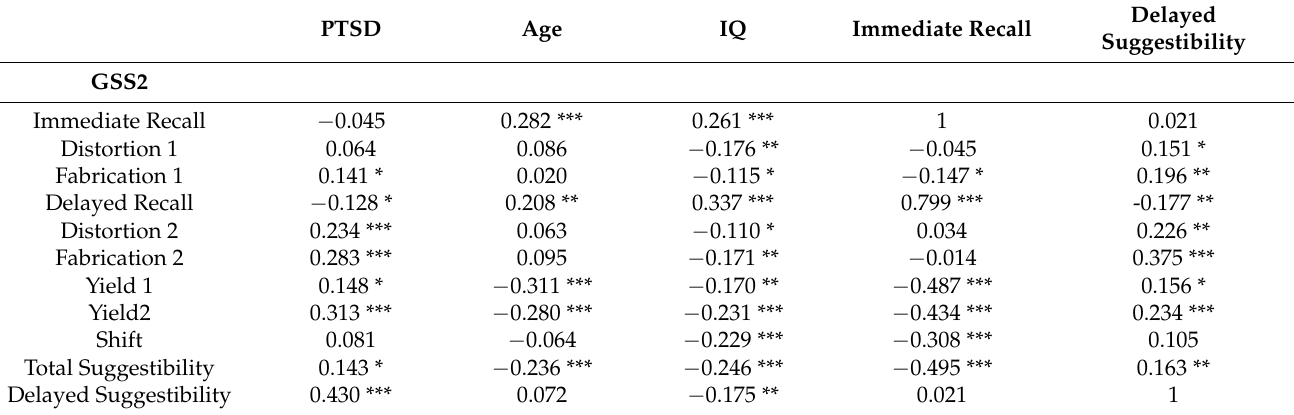
Table 1. Pearson’s correlation between GSS2, post-traumatic stress disorder (PTSD), age, and IQ ( n = 221). PTSD Age IQ Immediate Recall